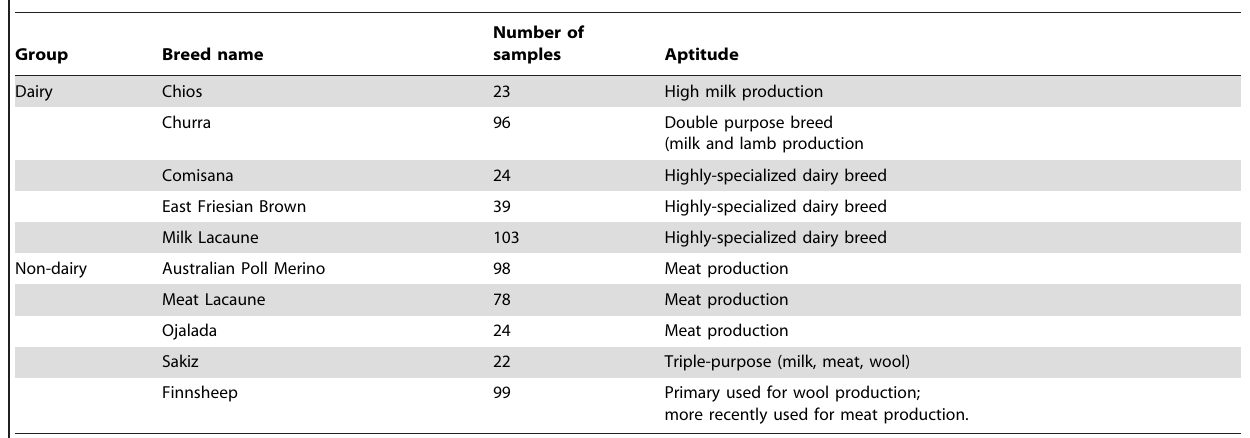
Table 1. Breeds included in the present